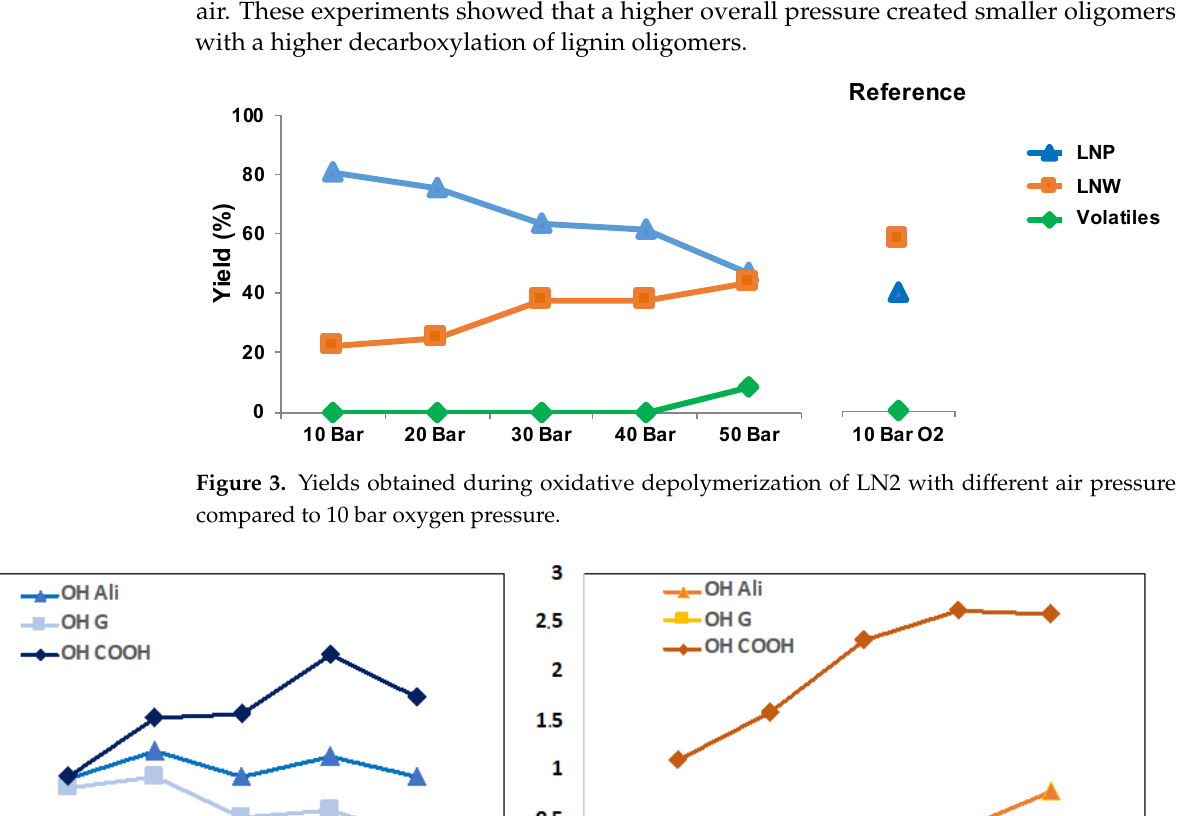
Figure 3. Yields obtained during oxidative depolymerization of LN2 with different air pressure compared to 10 bar oxygen pressure.